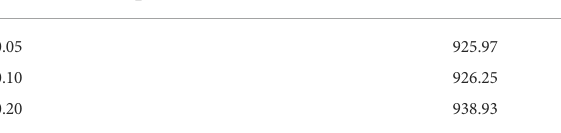
TABLE 1 PSCM with different risk tolerance parameters.